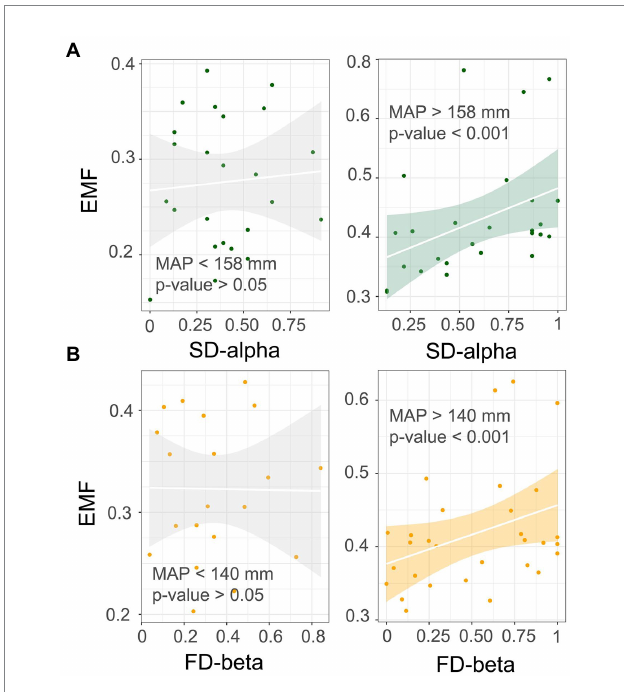
FIGURE 4 Validation of the relationship between diversity and multifunctionality at different scales under mean annual precipitation (MAP) thresholds. (A) alpha diversity; (B) beta